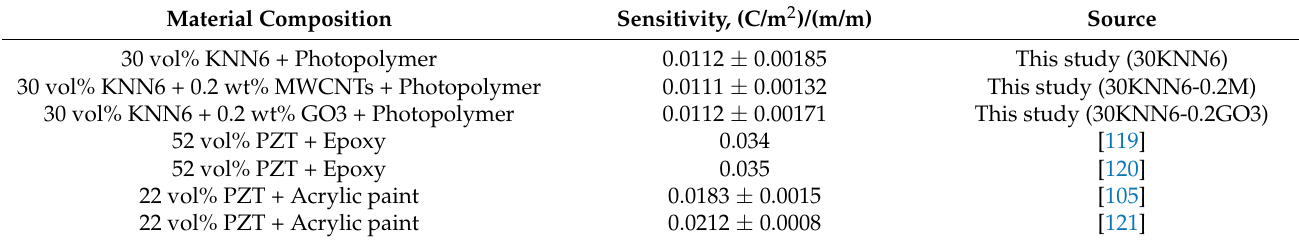
Table 3. Comparison of sensitivity of piezoelectric composite